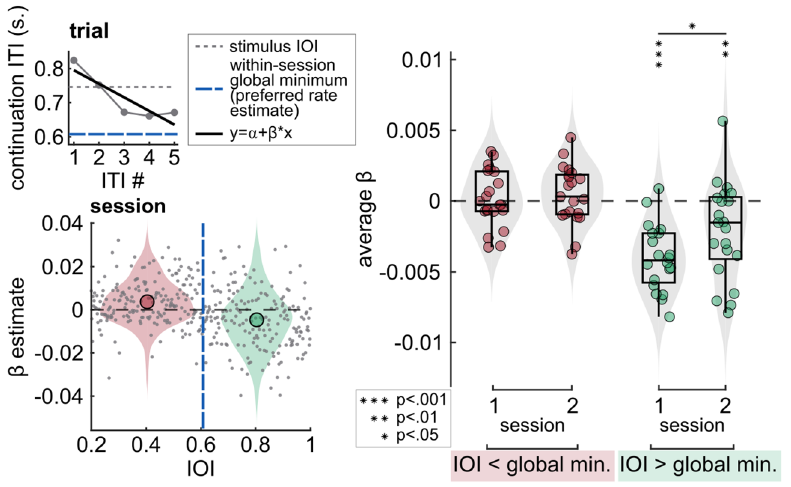
Figure 3. Results of the drift analysis. Left, top: Linear fits to an example trial’s tapping data. Connected dots represent the continuation ITIs, dashed lines are stimulus IOI (grey), and participant’s within-session global minimum estimate, i.e., preferred rate (blue). Drift on individual trials was quantified as the slopes (β) of the fitted least-squares lines (black). Left, bottom: β estimates obtained from an example participant’s single-session data. Gray dots represent β from individual trials. The dashed blue line represents the participant’s preferred rate estimate (within-session global minimum). Circle on the left (red) is the mean of β values obtained from the trials where IOI was faster than the preferred rate estimate, circle on the right (green) is the mean of β values obtained from the slower-than-preferred rate trials. Right: Distribution of β estimates, averaged within individual sessions. Each circle represents an individual’s average β. Average β from trials where stimulus IOI was faster than the individual’s preferred rate estimate are marked in red, average β from trials where stimulus IOI was slower than the individual’s preferred rate estimate are marked in green. Box plots show median (black vertical line), 25th and 75th percentiles (box edges) and extreme datapoints